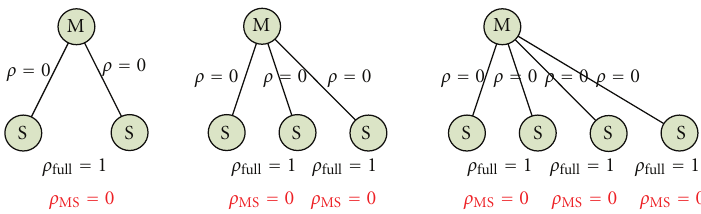
Figure 13: Worst cases for Master-Slave modelling: there is no correlation between master and slave satellites ( ρ = 0), but full correlation between the slaves ( ρ slaves = 1).